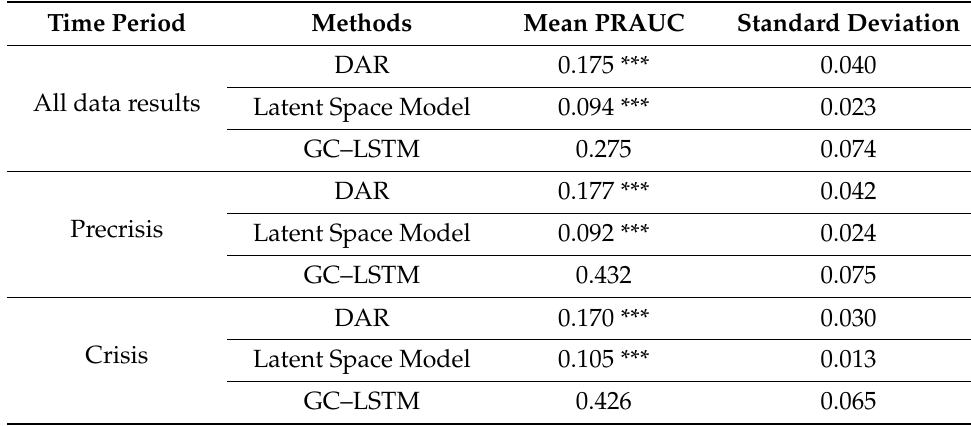
Table 6. PRAUC score for three models in the core country banks. The significance level of 1% (***) is used to assess the mean difference between the crisis and the precrisis period with the t